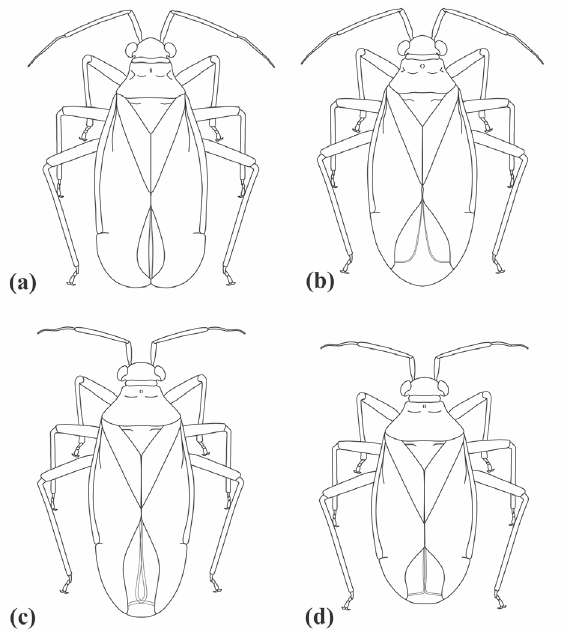
Figure 5. Dorsal view of Neoneella Costa Lima 1942 and Proneella Carvalho 1960. (a-b) Neoneella zikani Costa Lima 1942; (c-d) Proneella peruana Carvalho 1960 ; (a, c) male; (b, d)